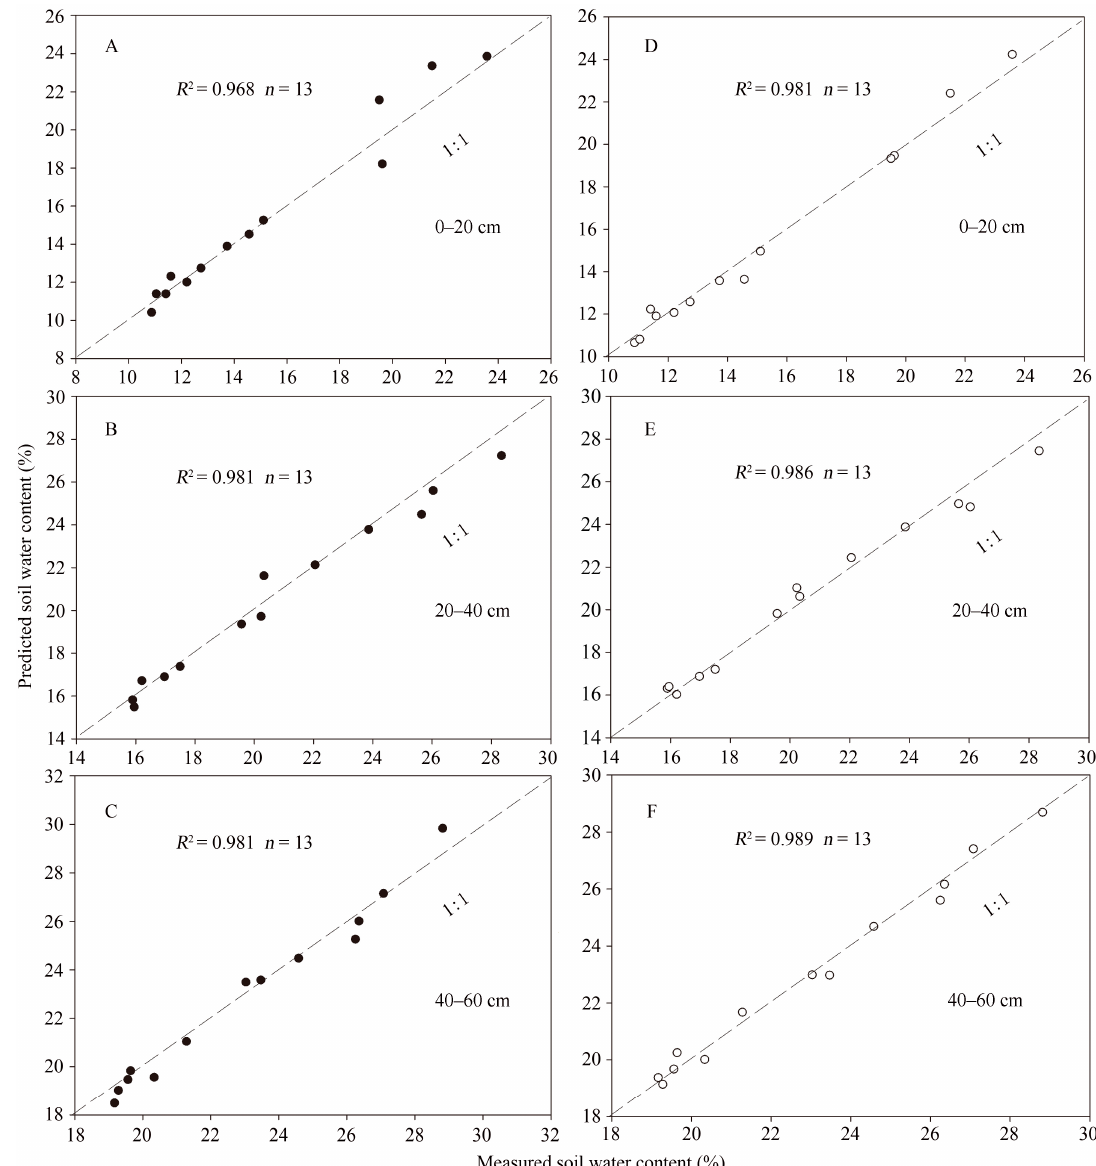
Figure 9. The measured and predicted slope mean VSM of each of the sampling dates for different soil layers using direct ( A – C ) and indirect ( D – F ) methods.